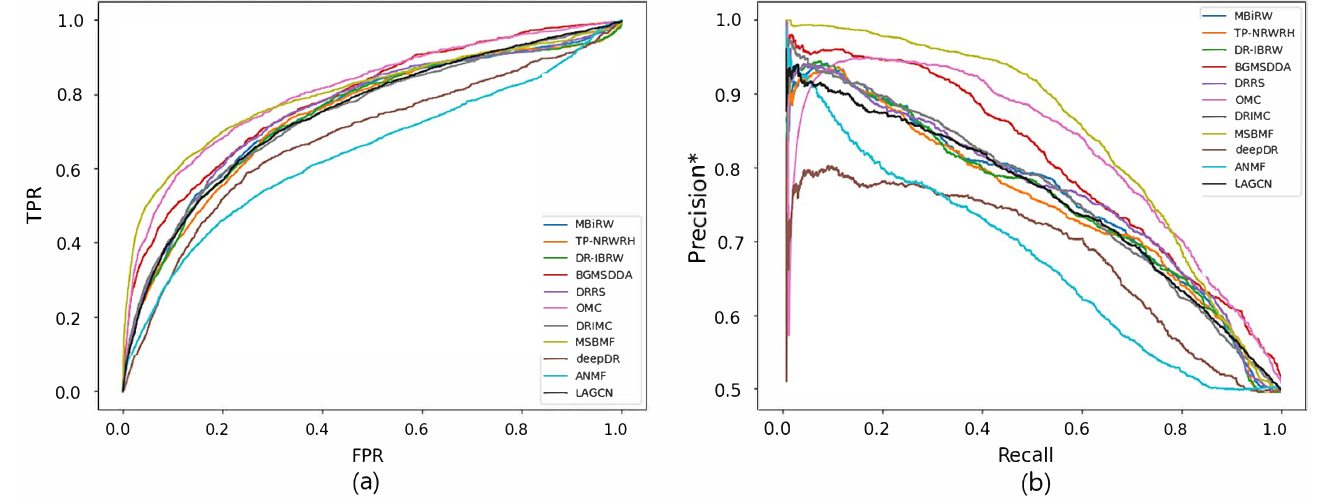
Figure 2. ROC curve ( a ) and precision*-recall curve ( b ) of drug-disease association prediction results for new drugs with